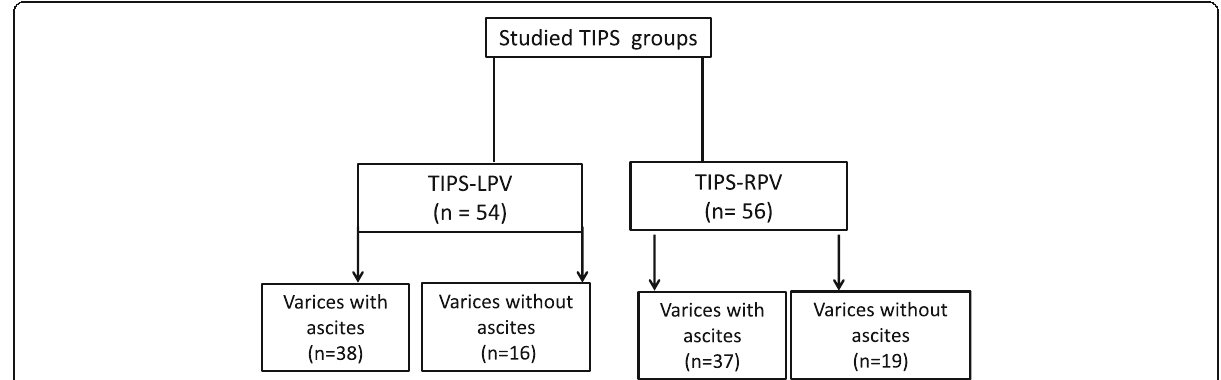
Fig. 1 Flowchart showing the patients in both TIPS groups